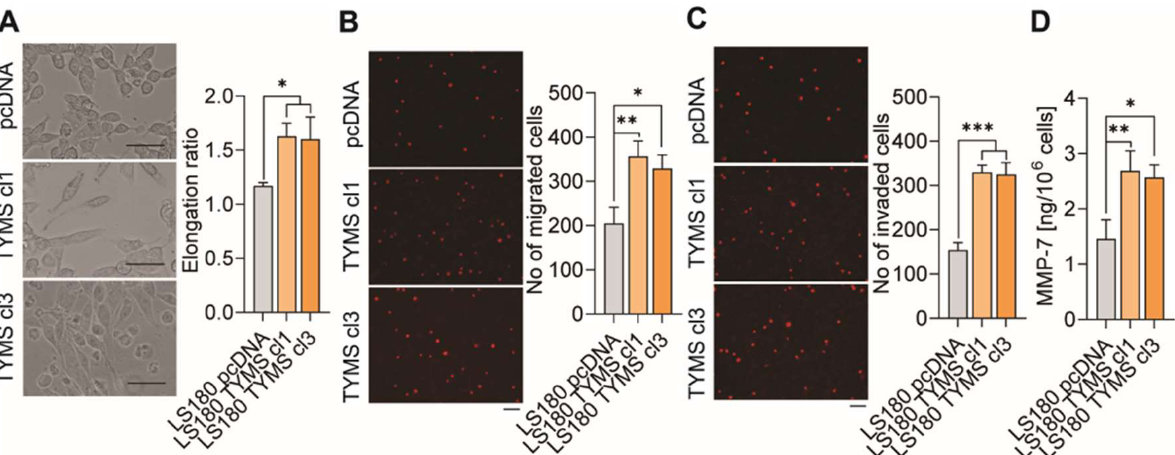
Figure 3. TYMS overexpression cells exhibited an increased invasive phenotype. Cells invasive abilities were evaluated by ( A ) cell elongation, ( B ) cell migration, ( C ) cell invasion assay, and ( D ) MMP- 7 secretions. The representative images are shown. Scale bar 100 µm. The graph displays means ± SD ( n = 3). ns—non-significant * p < 0.05, ** p < 0.01, *** p < 0.001.